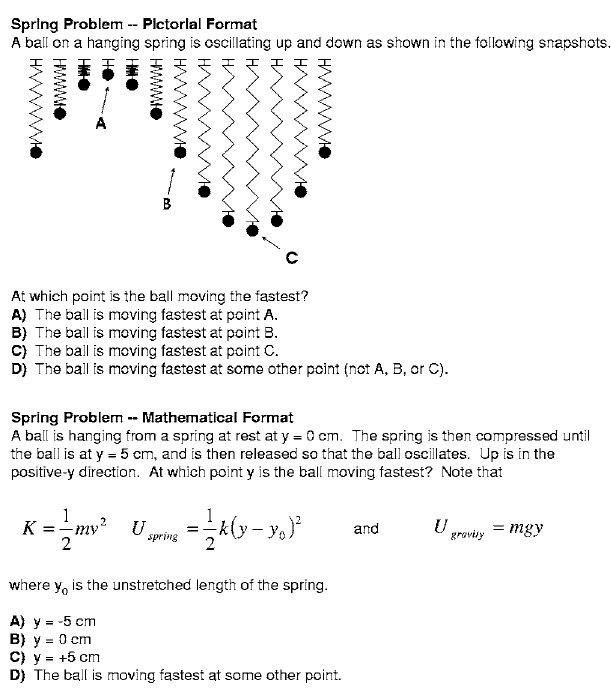
FIG. 3. Pictorial and mathematical representations of the quiz on springs given in Physics